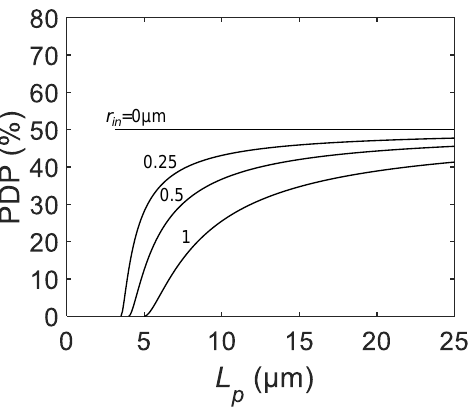
Figure 3. The calculated PDP as a function of the SPAD pixel pitch L p for PDP max = 50%, active-to- active distance L a − a = 3 µ m, and inactive radius r in = 0, 0.25, 0.5, and 1 µ